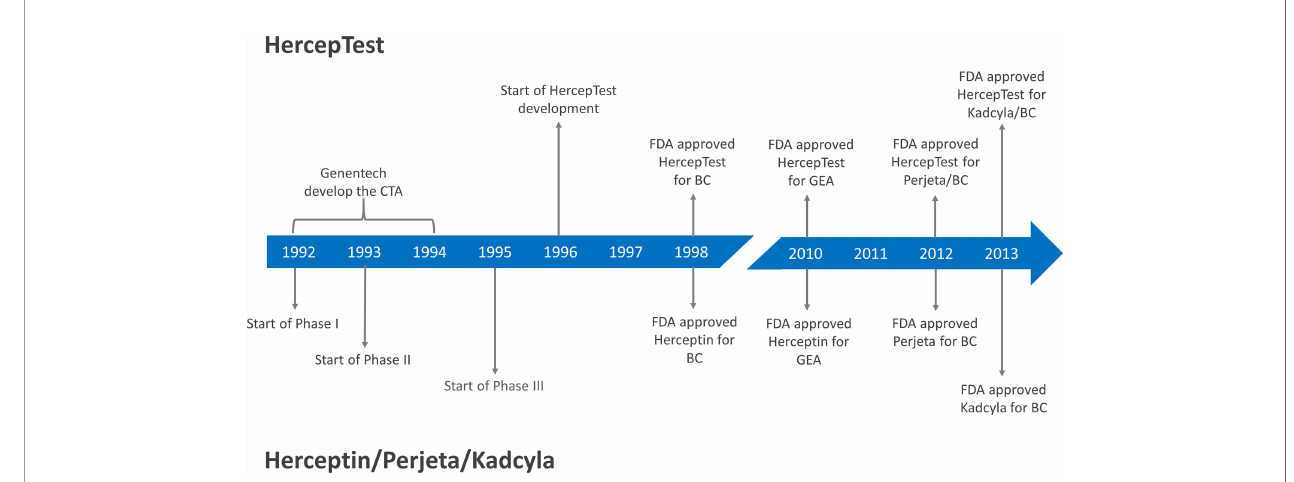
FIGURE 1 | Milestones for the development of HercepTest ™ and different HER2 targeted therapies. CTA, ClinicalTrial Assay;FDA, Food andDrugAdministration;BC, Breast Cancer;GEA, Gastroesophageal junction adenocarcinoma; Herceptin ® , trastuzumab;Perjeta ® , pertuzumab;Kadcyla ® , ado-trastuzumab